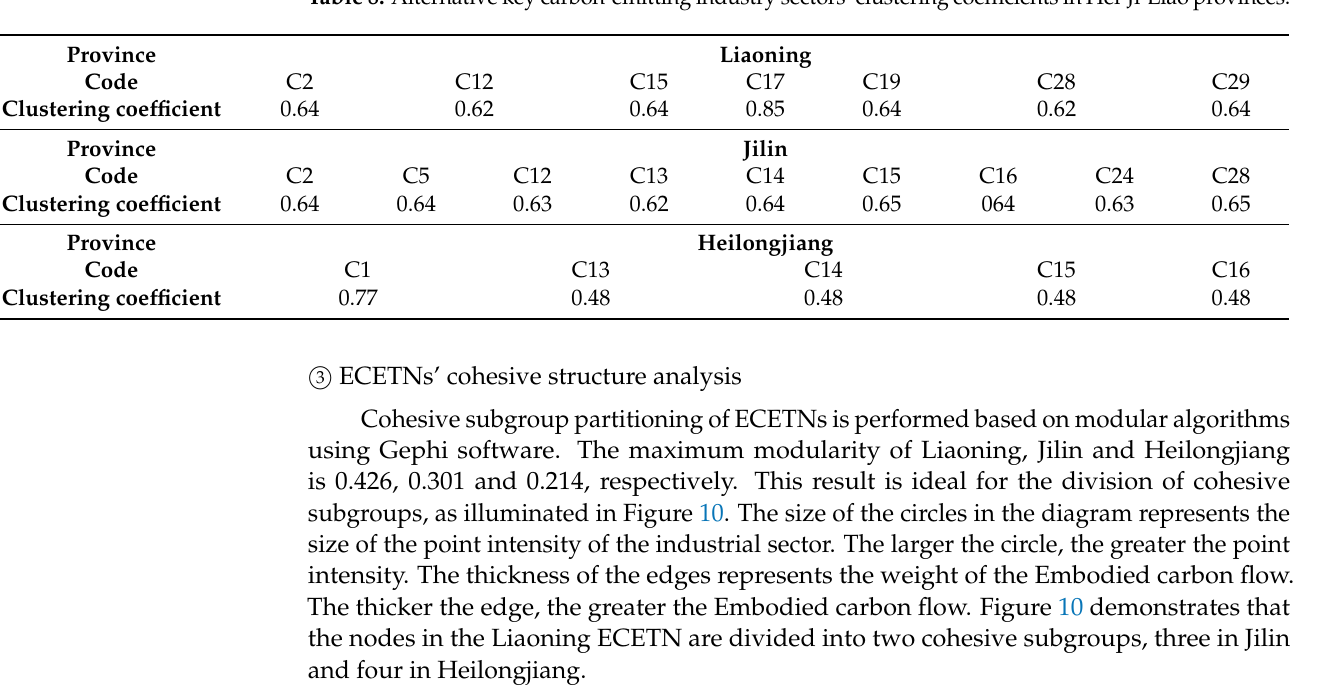
Table 8. Alternative key carbon-emitting industry sectors’ clustering coefficients in Hei-Ji-Liao provinces.